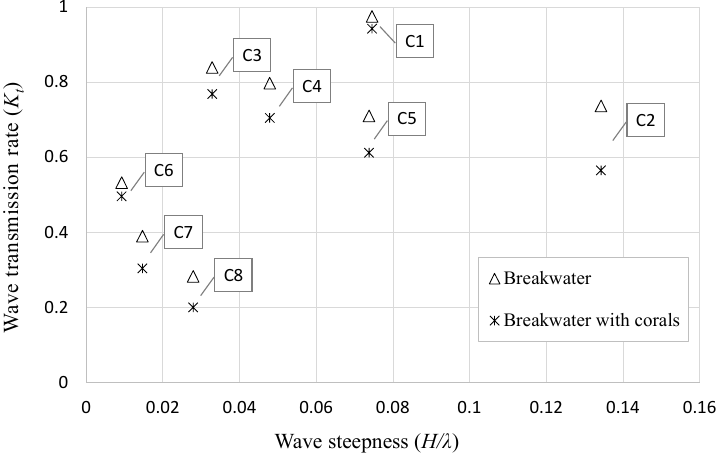
Figure 4. Wave-transmission rate for the two configurations of the reef model under a water depth h = 0.55 m.